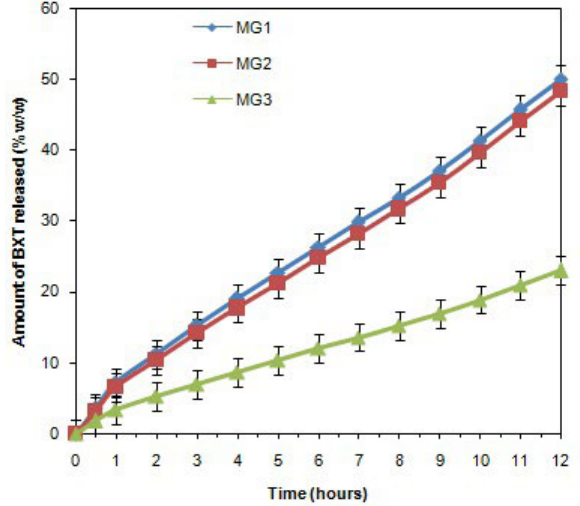
Figure 7. In vitro dissolution release of BXT from BXT@MG